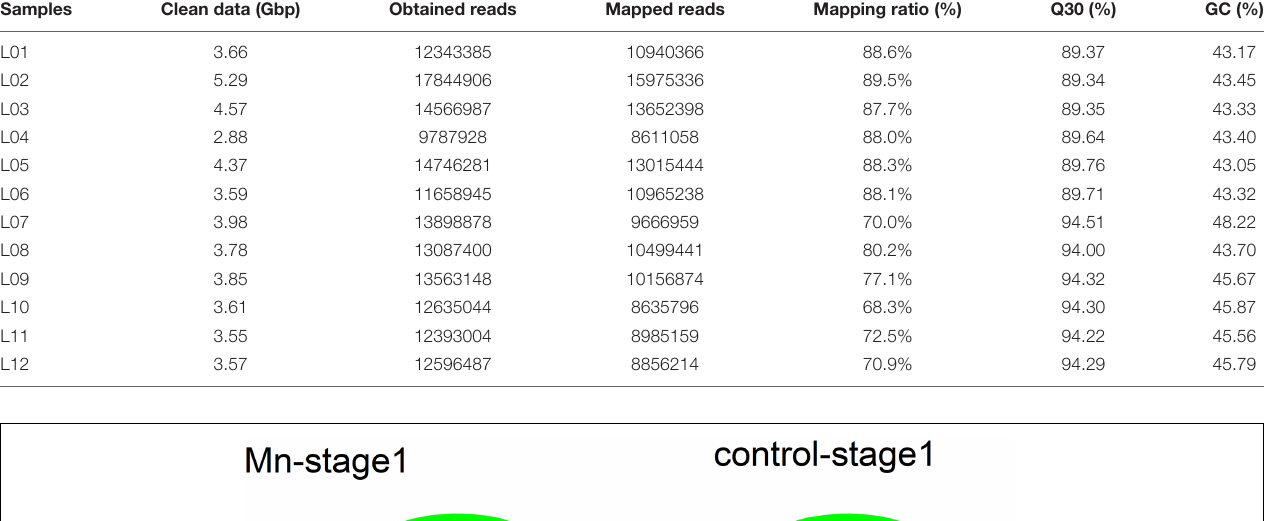
TABLE 1 | Statistical statement of transcriptome sequencing of B. safensis strain ST7. Samples